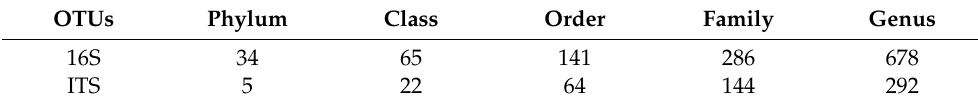
Table 2. Number of OTUs representing identified taxa from phylum to genus taxonomic levels.